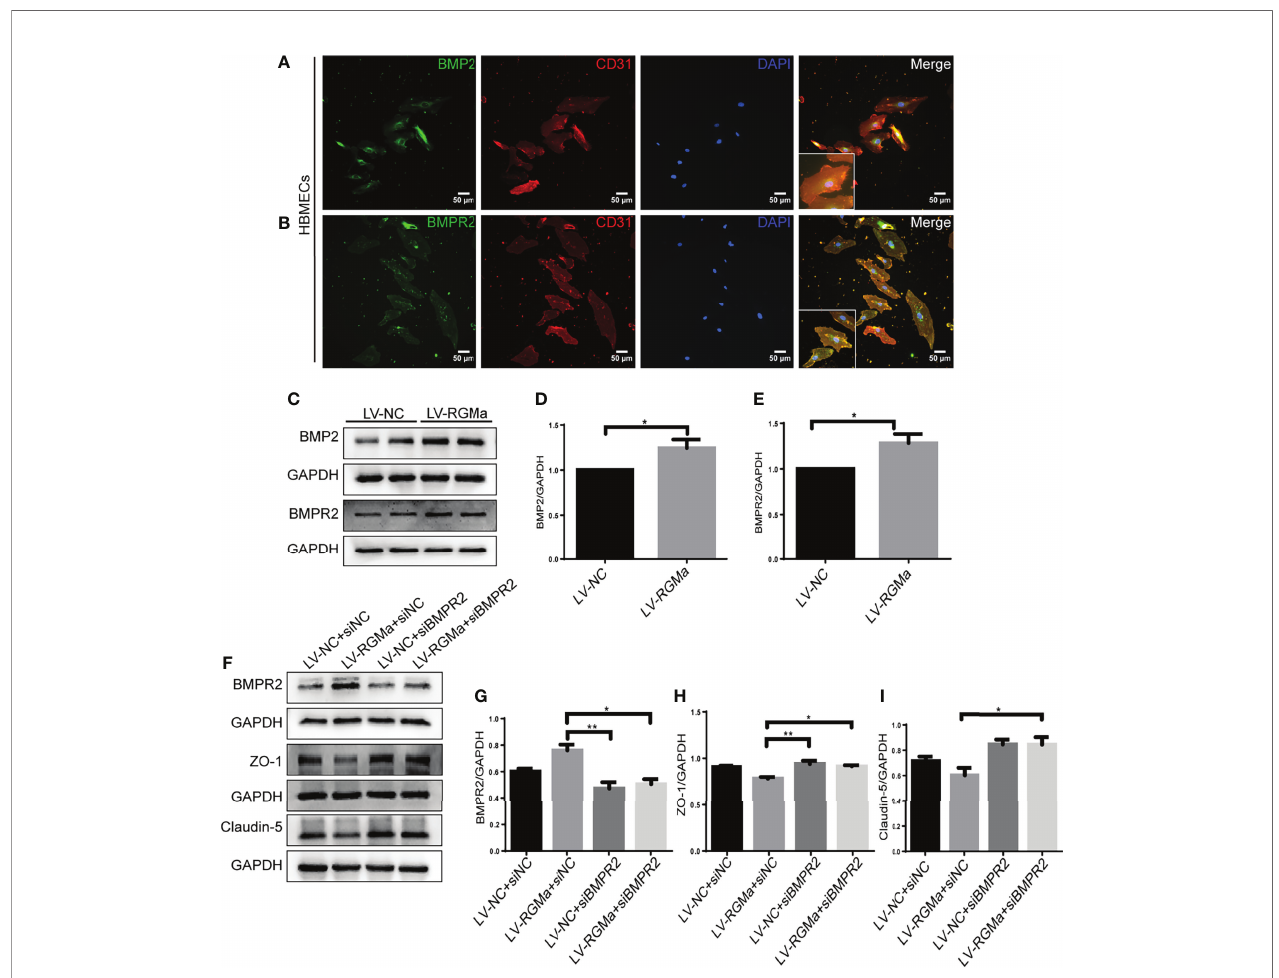
FIGURE 4 | BMPR II mediates the integrity of the BBB induced by RGMa. (A, B) Immuno fl uorescence showed BMP2 and BMPR II were expressed in HBMECs. Scale bar: 50 µm. (C – E) Both BMP2 and BMPR II expression levels were signi fi cantly increased after overexpressing RGMa ( n = 3, * p < 0.05, t -test). (F – I) On the basis of overexpressing RGMa, speci fi cally silencing BMPR II signi fi cantly augments ZO-1 and claudin-5 expression ( n = 3, * p < 0.05, t -test). **p <